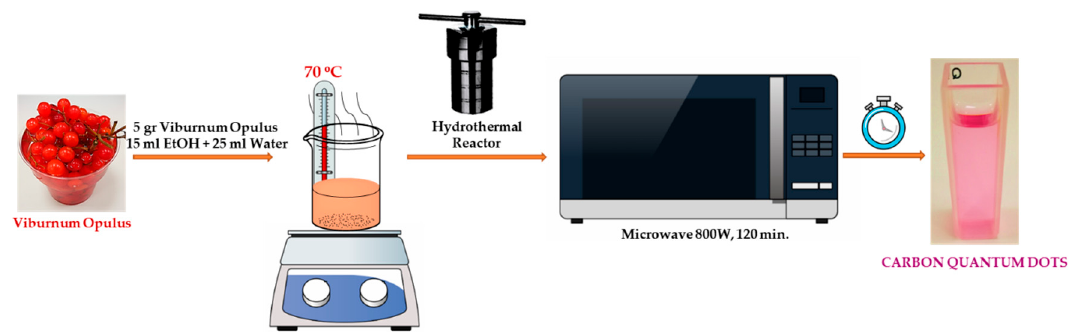
Figure 1. Fabrication of carbon quantum dots (C-dots) from Viburnum